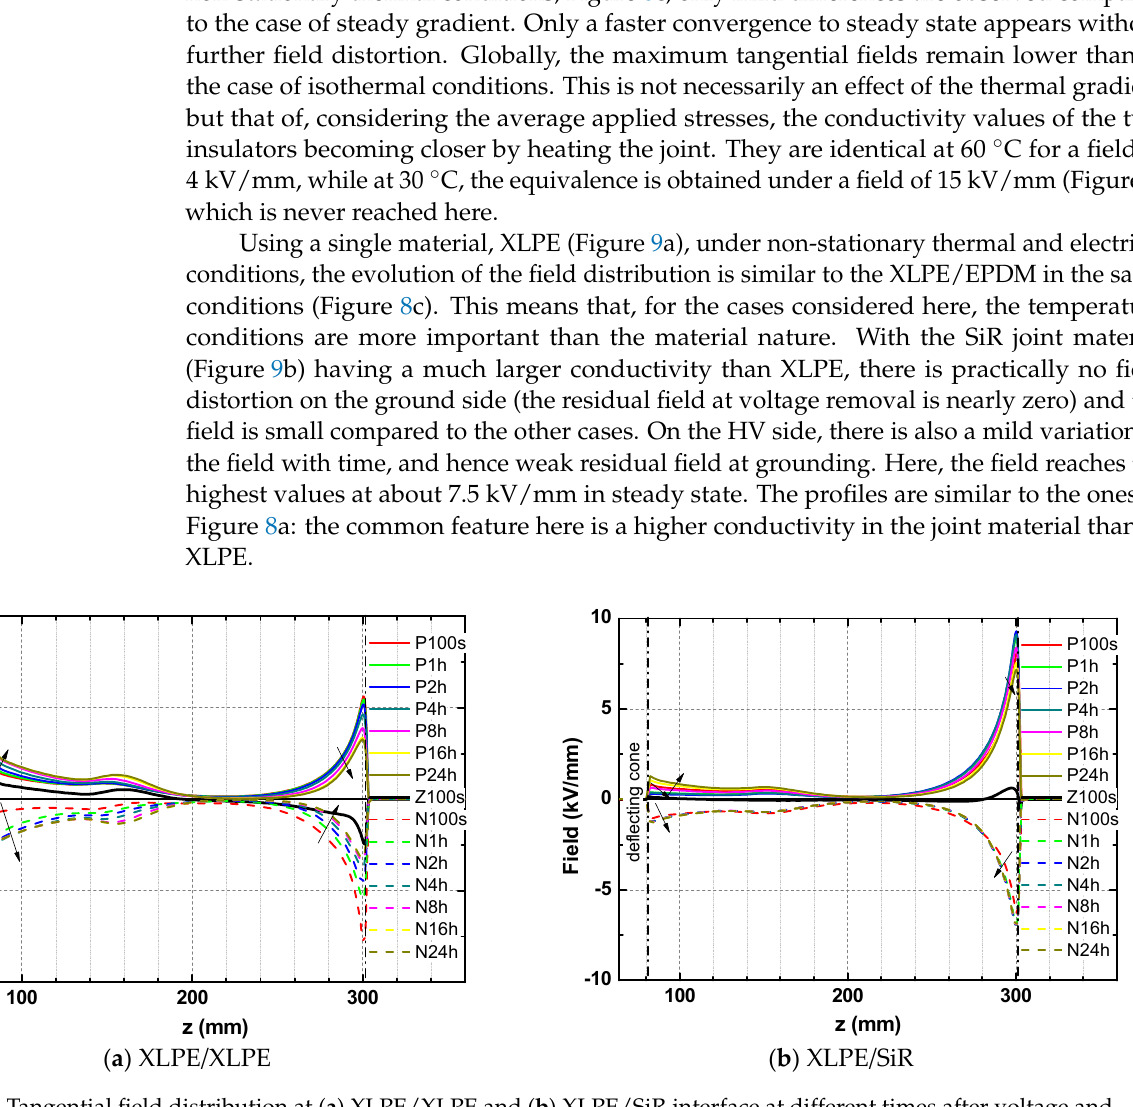
Figure 9. Tangential field distribution at ( a ) XLPE/XLPE and ( b ) XLPE/SiR interface at different times after voltage and current application (non-stationary electrical and thermal conditions). Vertical lines define insulator boundaries. Same conventions as in Figure 6.